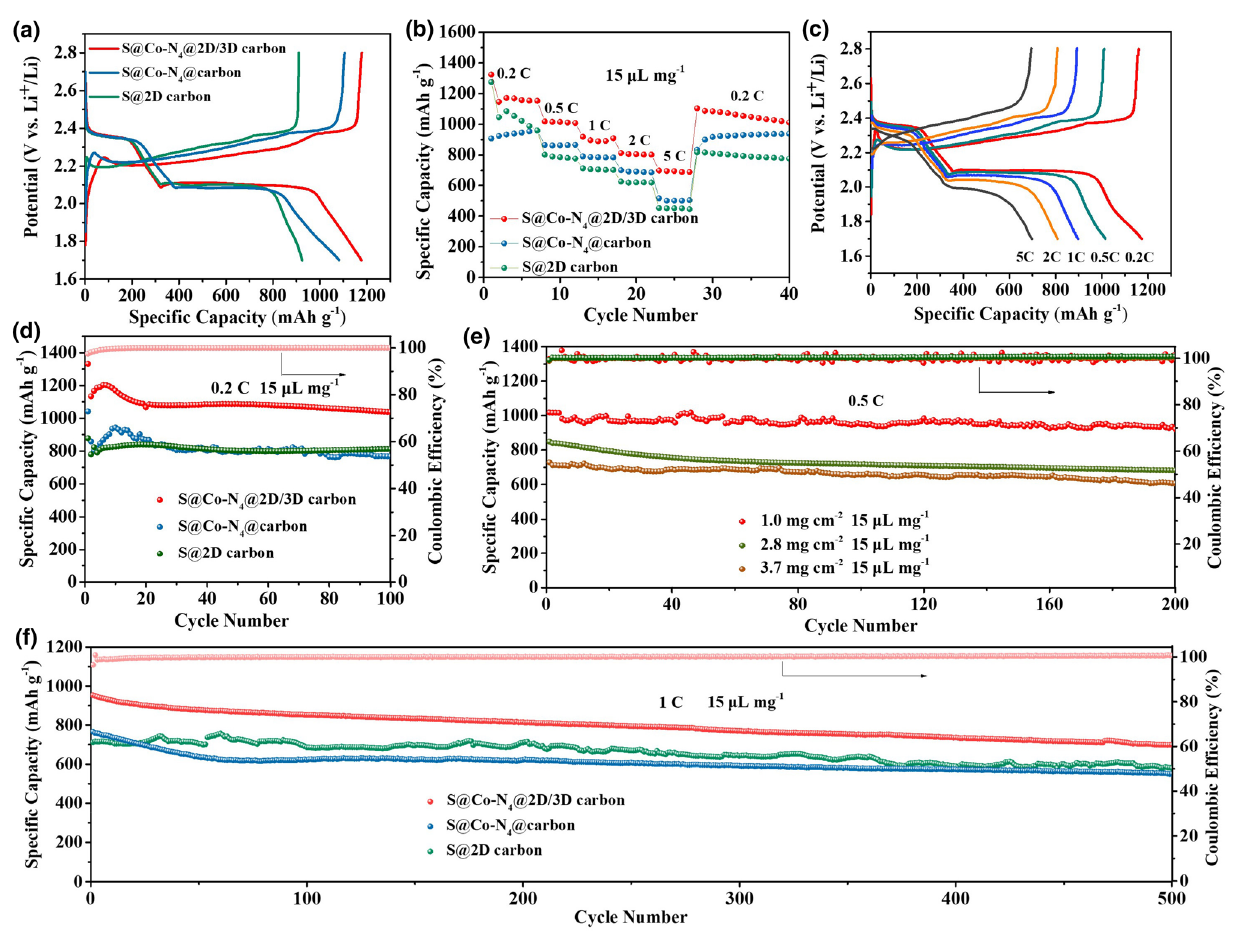
Fig. 6 a Charge–discharge profiles at 0.2 C and b rate performance at various current rate of S@Co–N 4 @2D/3D carbon, S@Co–N 4 @carbon and S@2D carbon electrodes. c The charge–discharge profiles of the S@Co–N 4 @2D/3D carbon electrode at different current rates. d Cycling stability at 0.2 C and f cycling stability at 1 C for S@Co–N 4 @2D/3D carbon, S@Co–N 4 @carbon and S@2D carbon electrodes. e Cycling per- formance of S@Co–N 4 @2D/3D carbon with sulfur loading of 1.0, 2.8, and 3.7 mg cm −2 at 0.5